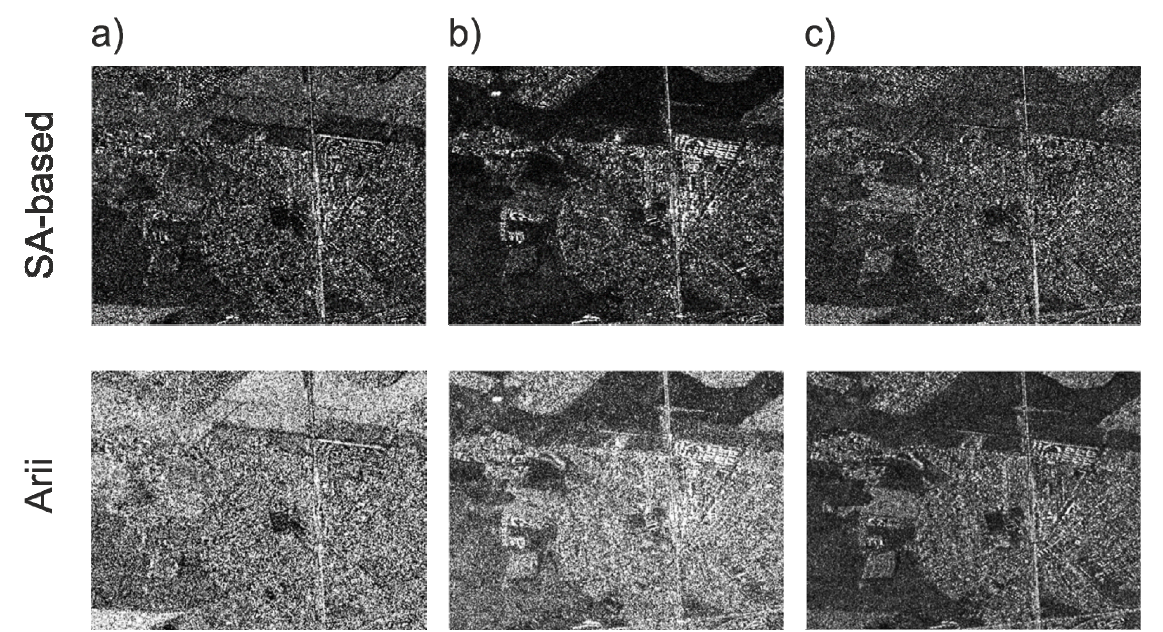
Figure 8. Results of the proposed SA-based and Arii decomposition: ( a ) decomposed single-bounce scattering powers, ( b ) decomposed double-bounce scattering powers, ( c ) decomposed volume-scattering powers.